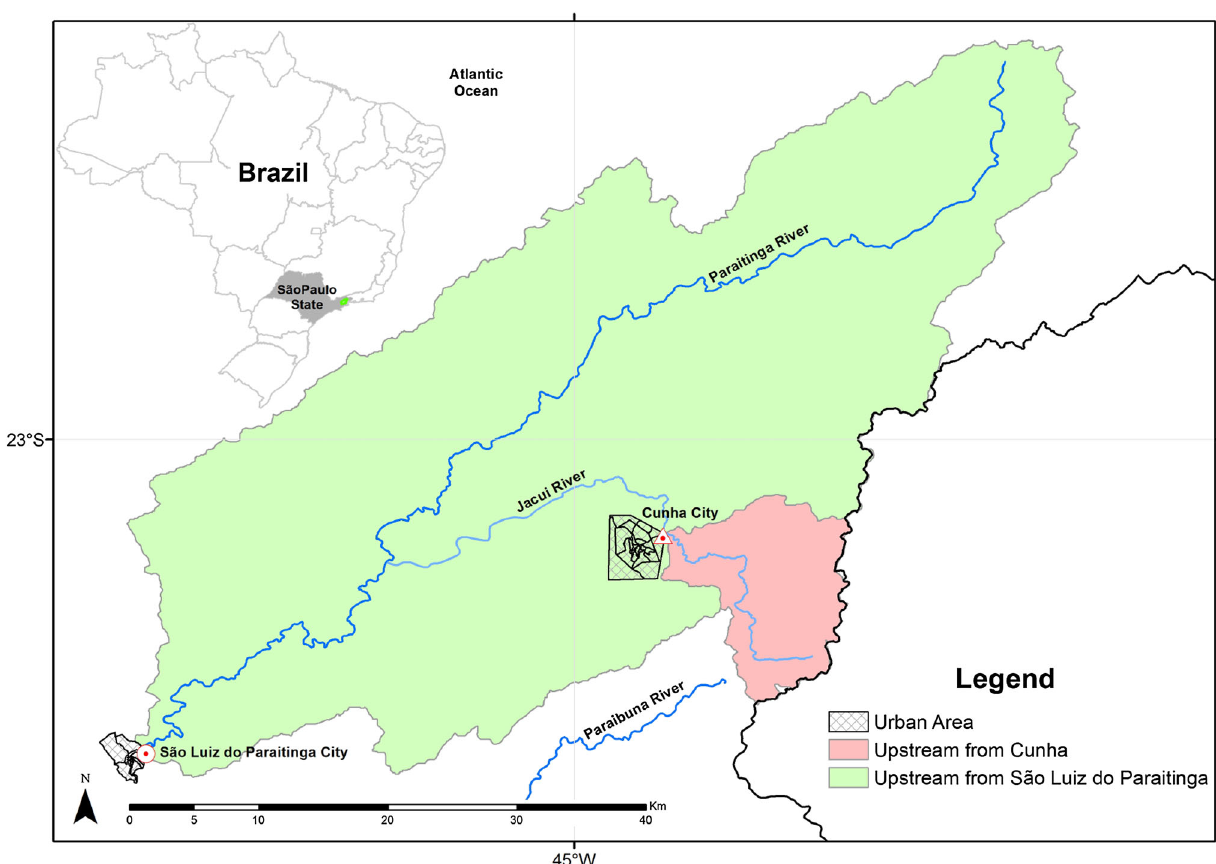
Fig. 1 The study area in Brazil. The cities of Cunha and Sa˜o Luiz do Paraitinga are located in the State of Sa˜o Paulo, in the southeast region of Brazil. Cunha is located on the Jacui River and Sa˜o Luiz do Paraitinga is located on the Paraitinga River. Both catchment areas